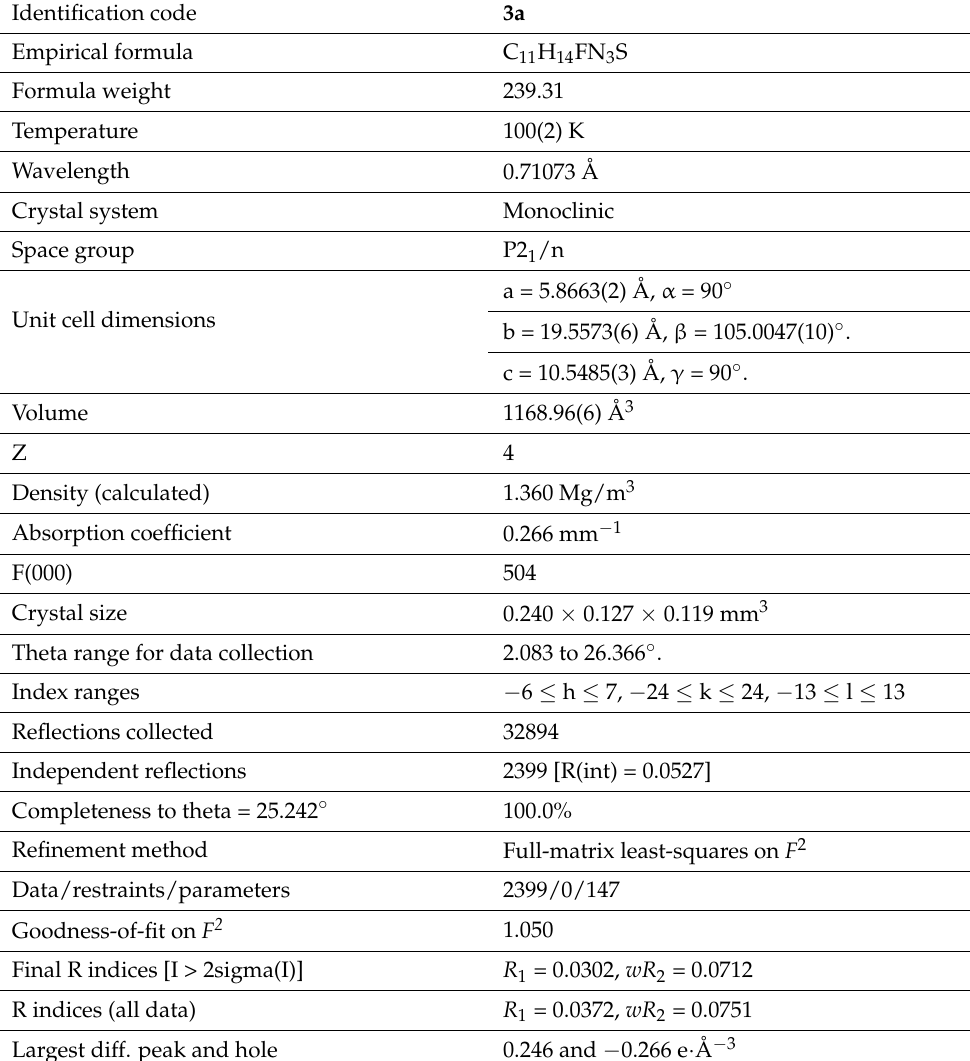
Table A1. Crystal data and structure refinement for 3a